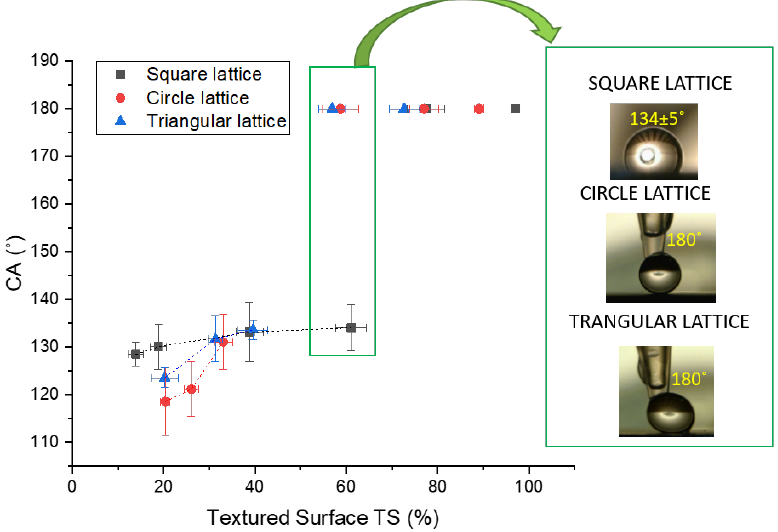
Figure 8. Evolution of the contact angle (CA) as a function of the percentage of the textured surface (TS) for the three different textures and a droplet volume of 2 µ L. In the green rectangle, the images of the deposited droplet on the 60% textured samples are highlighted.